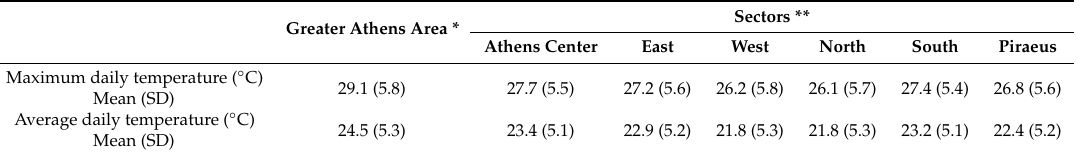
Table 1. Temperature from the central fixed-site Thissio and from the E-OBS dataset, 1 / 04 to 30 / 09, 2000–2012.